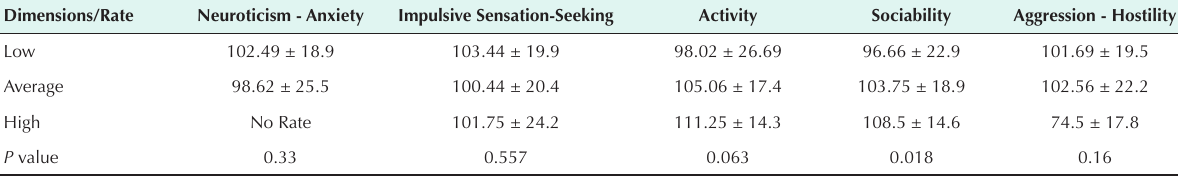
Table 1. Comparative Score of Attitude to Students' Communication Skills Based on Personality Dimensions